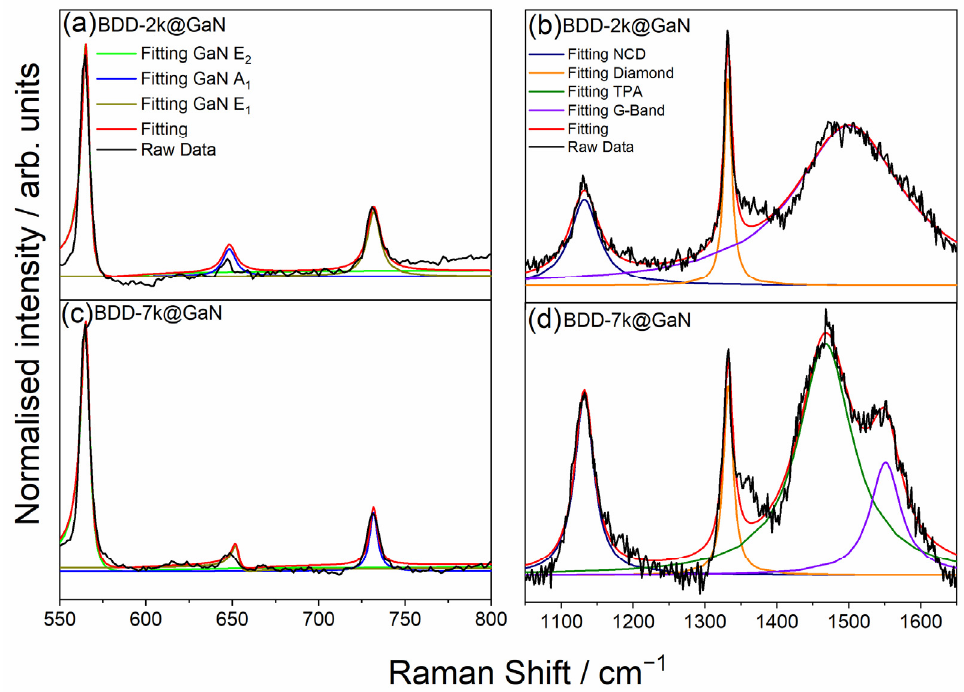
Figure 4. Normalised Raman spectra modelled using the Breit-Wigner-Fano function: ( a , b ) BDD2k and ( c , d ) BDD7k.